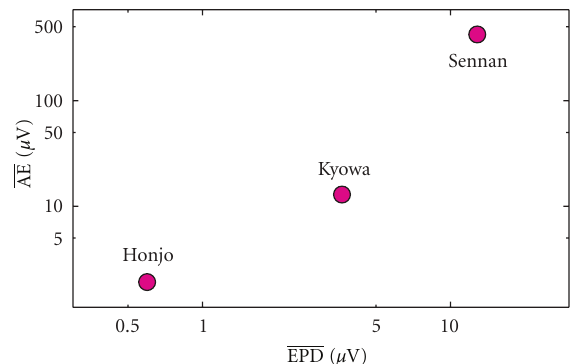
Figure 5: Positive correlation between the average of the induced earth potential di ff erence (EPD) and the average of the induced atmospheric electricity